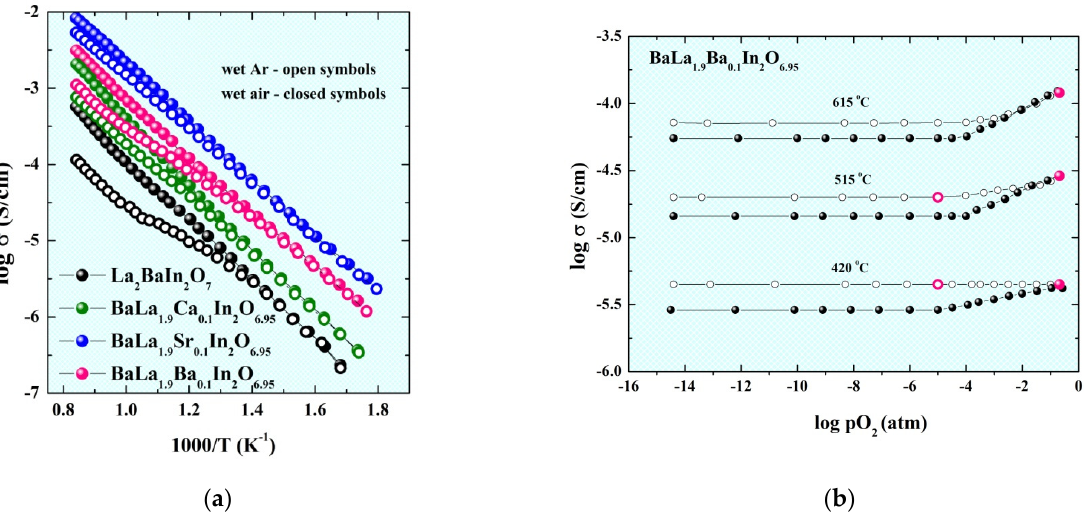
Figure 6. The temperature dependencies of conductivity for the investigated compositions obtained under wet air and wet Ar ( a ) and the dependencies of the conductivity values vs. oxygen partial pressure for the composition BaLa 1.9 Ba 0.1 In 2 O 6.95 under dry (filled symbols) and wet (open symbols) conditions and conductivity values from σ –1000/T dependencies under wet air (filled pink symbols) and wet Ar (open pink symbols) conditions ( b ).